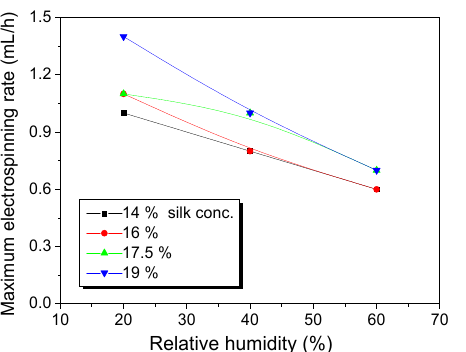
Figure 1. Effect of relative humidity on the maximum electrospinning rate of regenerated silk formic acid solutions with different silk concentrations.